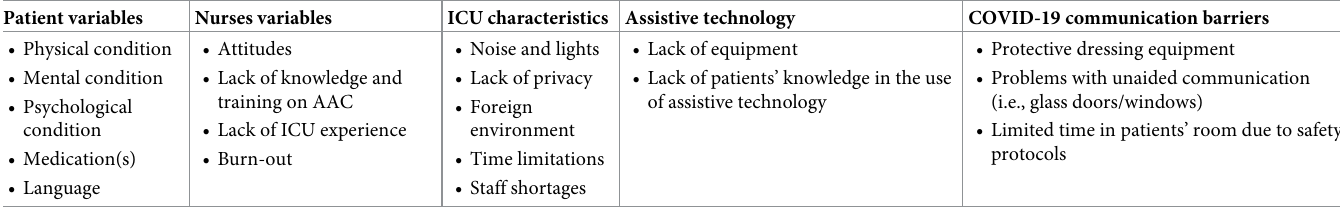
Table 4. Categories and Sub-categories of communication